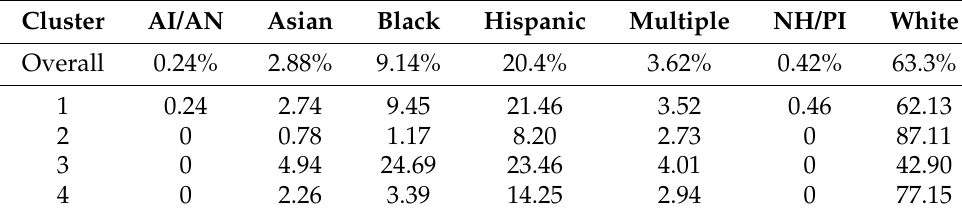
Table 5. Percentage of individuals who fall into racial categories for overall sample of 10,000 and for each of the four clusters. AI/AN is American Indian/Alaska Native, and NH/PI is Native Hawaiian/other Pacific Islander. Given as percentages.